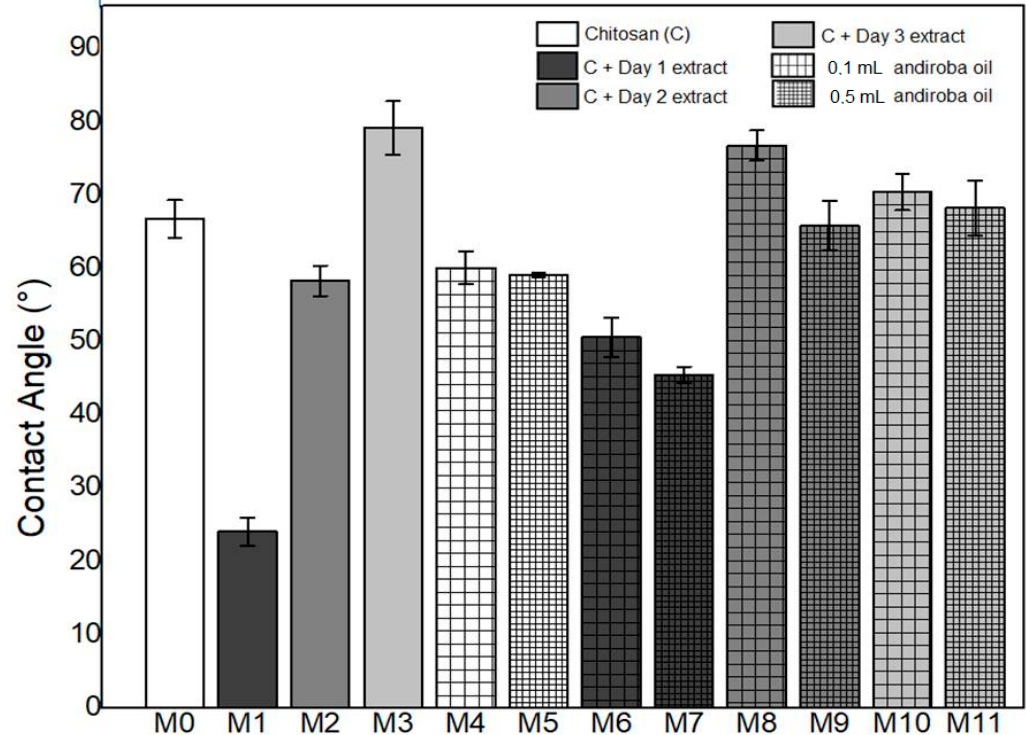
Figure 5. Comparison between the means of the values of the contact angles of the membranes.